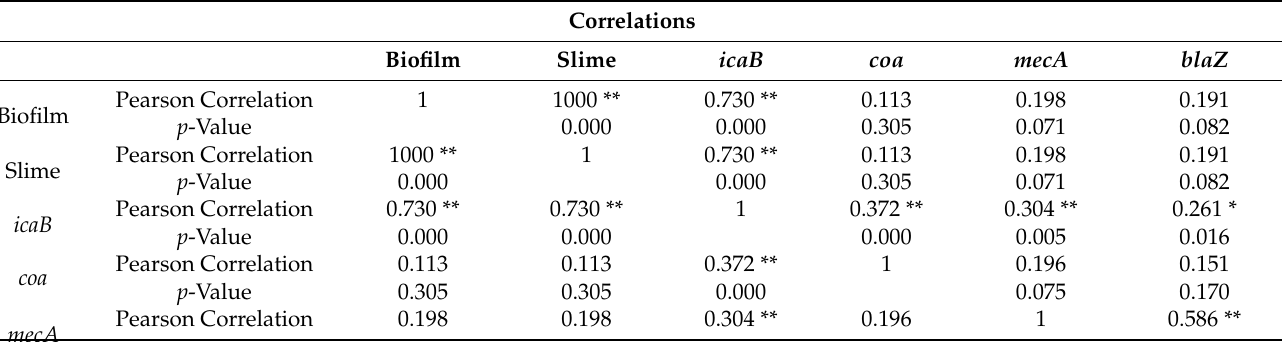
Table 3. Correlations between virulence features.